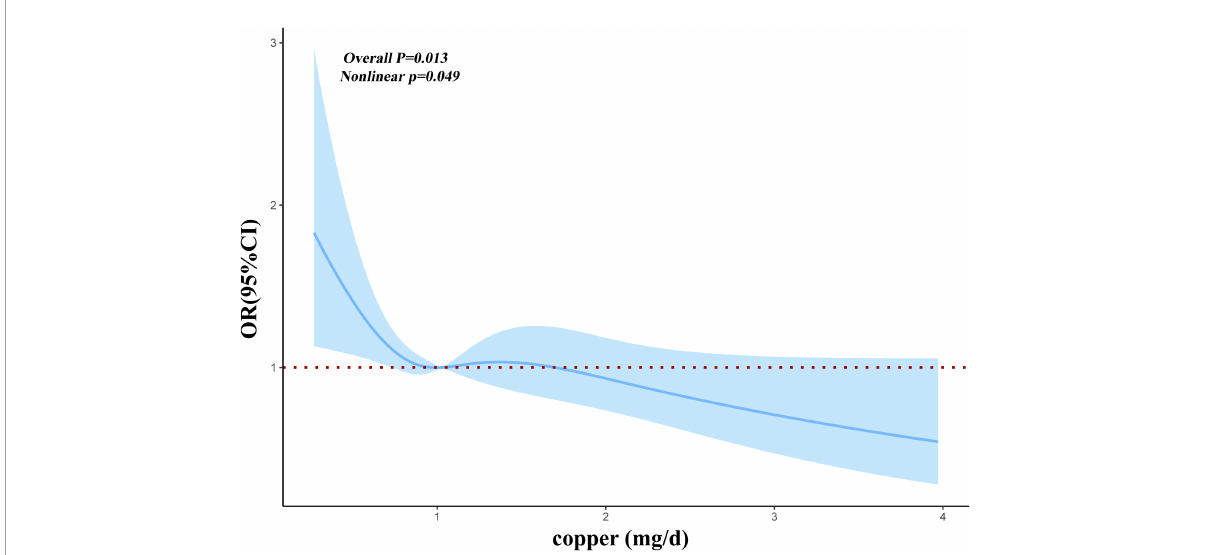
FIGURE3 Restricted cubic spline models for the relationship between dietary copper intake and the risk of myocardial infarction after matching.